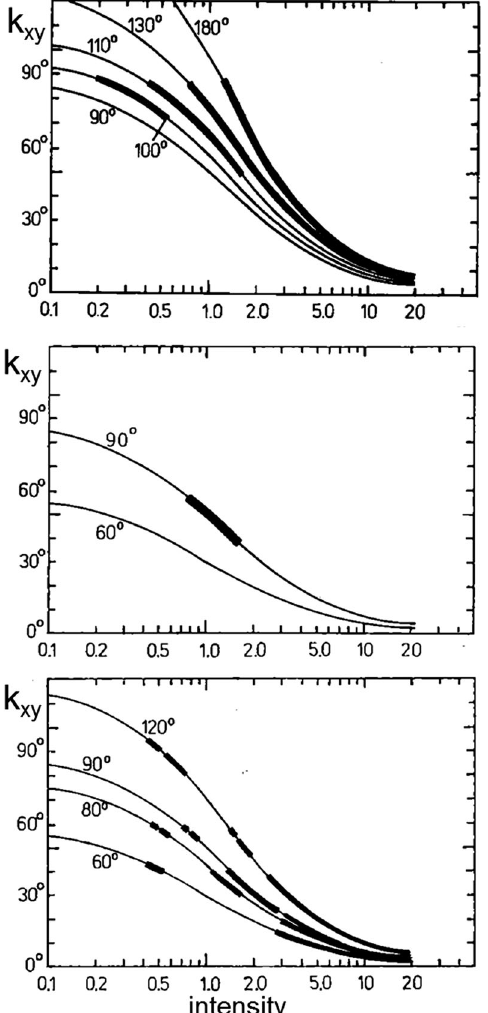
FIG. 3. Stopbands of second order (top, envelope instability), third order (center) and fourth order (bottom) parametric reso- nances as function of a dimensionless intensity parameter. Each curve relates intensity to k x;y for a fixed value of k 0 ;x;y (in degrees) (source: Ref.